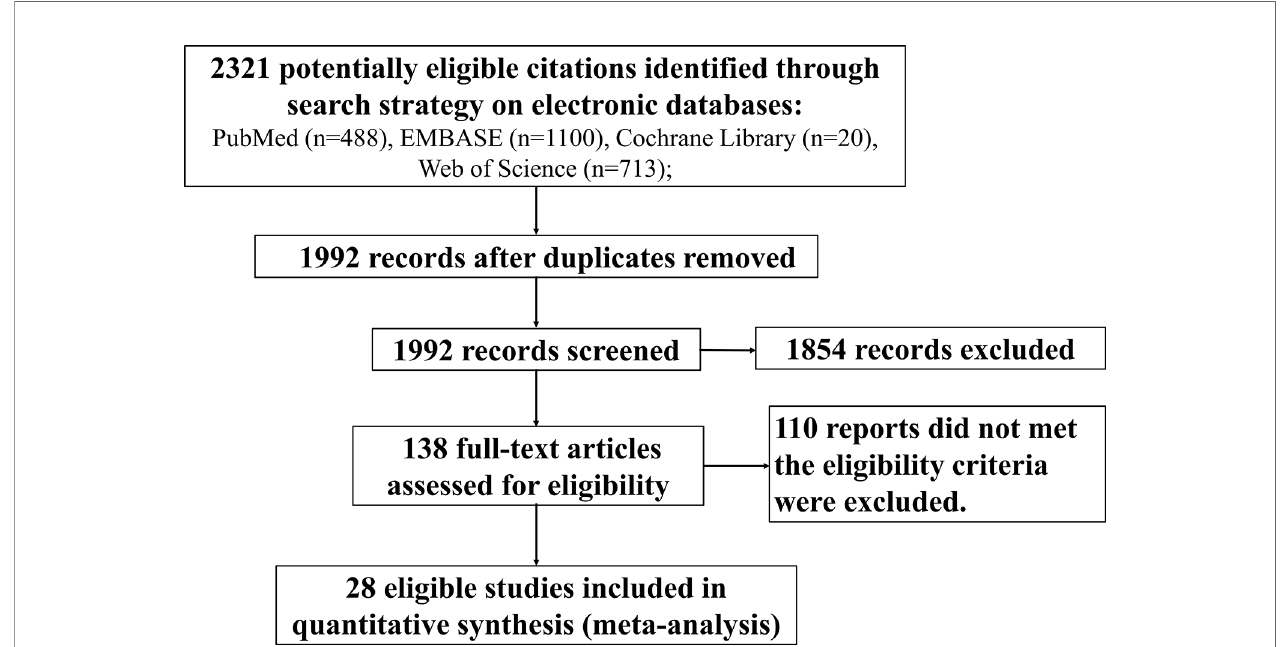
FIGURE 1 | Flowchart depicting the systematic search conducted to identify eligible studies that reported frequency of HIV-1 seronegativity.